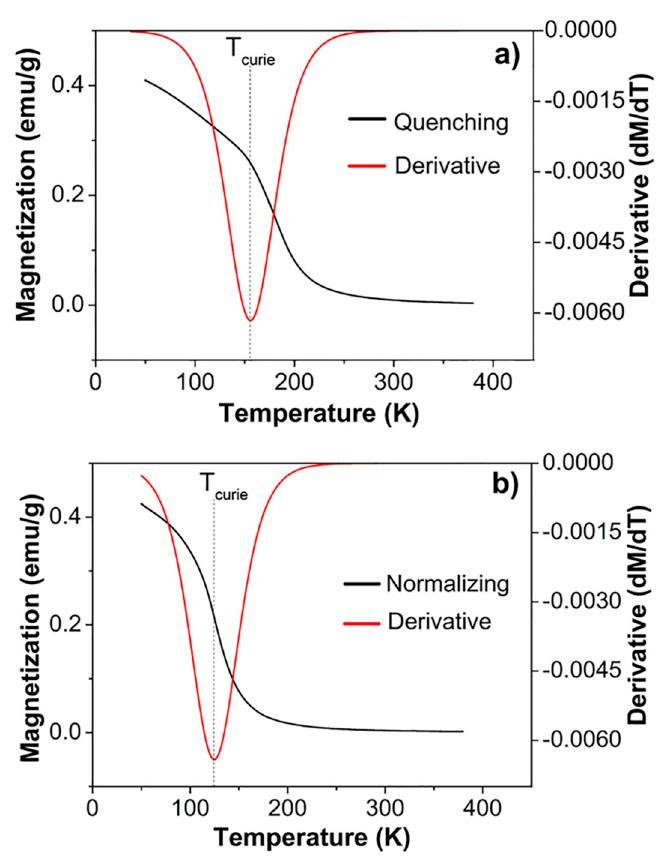
Figure 4. Curie temperature ( T curie ) as a function of thermal treatment: ( a ) quenching and ( b ) normalizing.